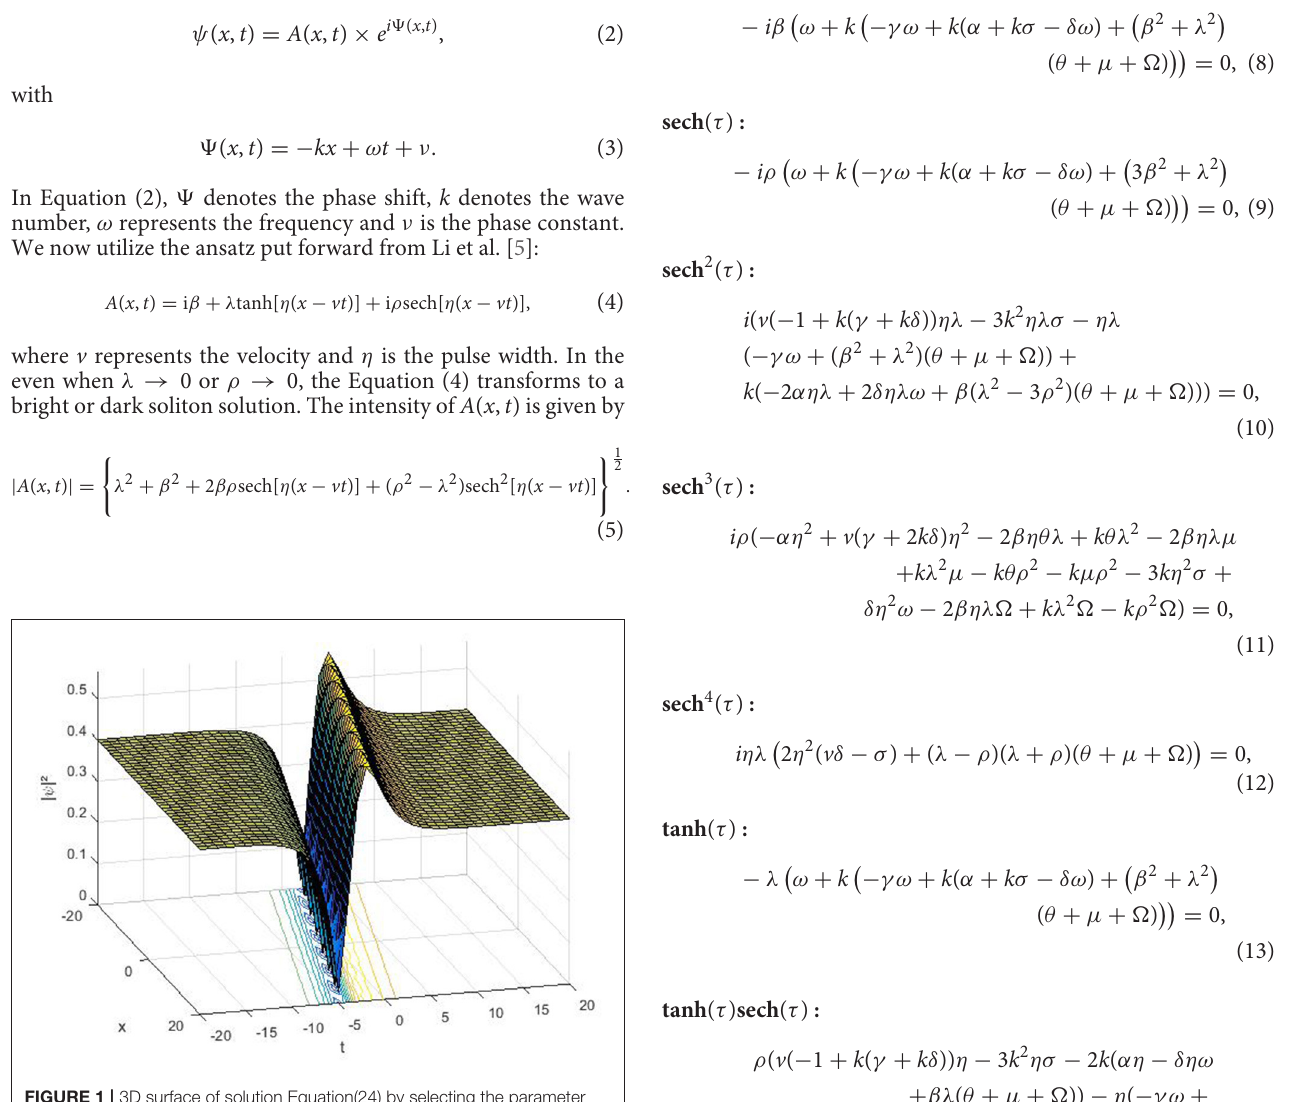
FIGURE 1 | 3D surface of solution Equation(24) by selecting the parameter values of η = 0.1, λ = 0.1, θ = 1, (cid:127) =